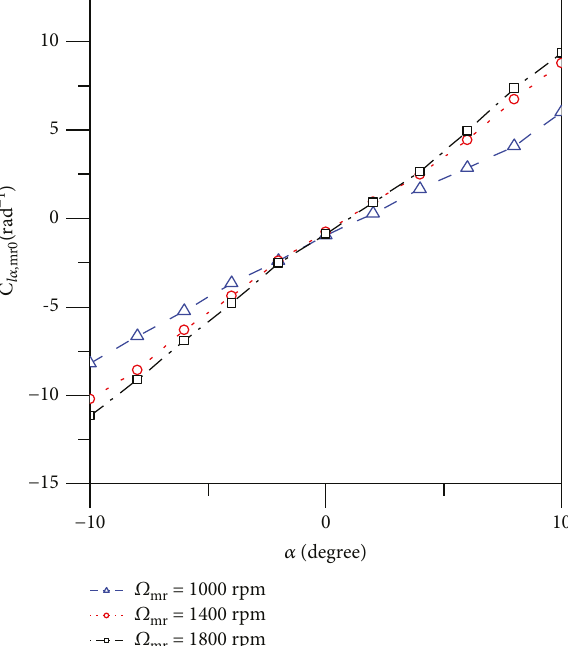
Figure 13: The value of the curve slope.